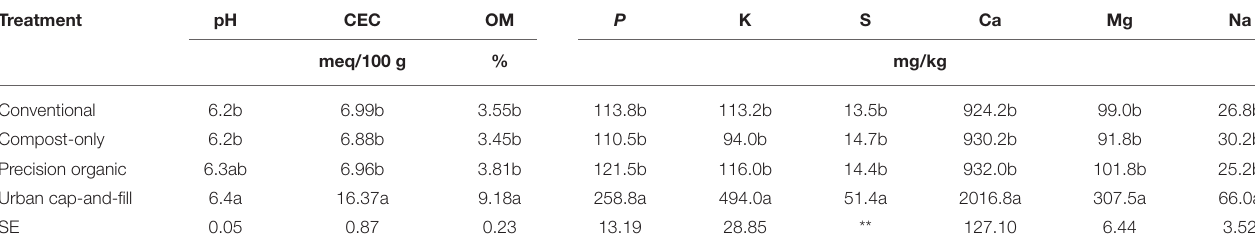
TABLE 5 | Baseline chemical properties of soils prior to application of fertilizer or compost but after establishment of urban cap-and-fill plots (May 2017). Treatment